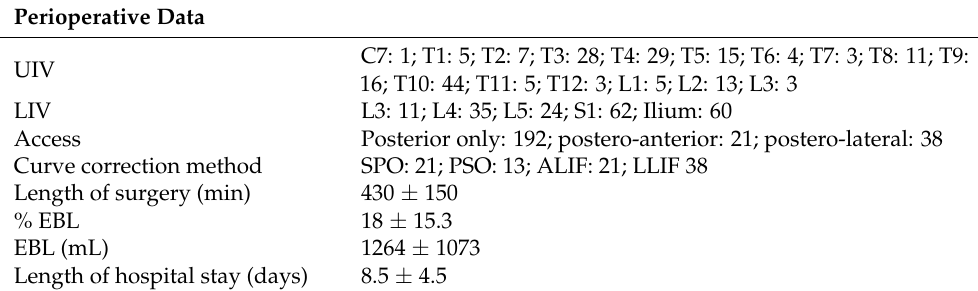
Table 3. Summary of perioperative data. Perioperative Data